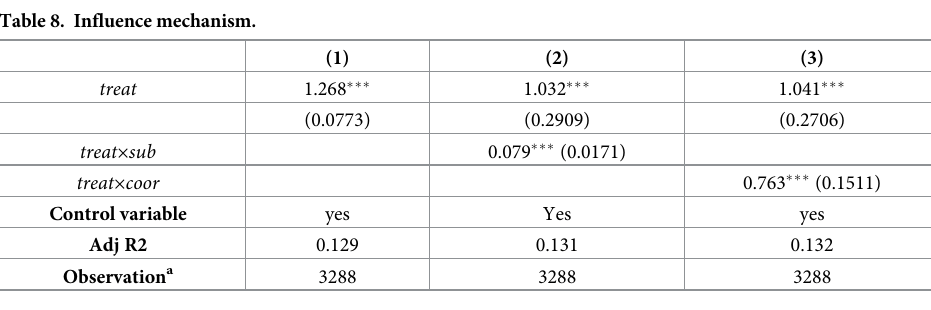
Table 8. Influence mechanism.